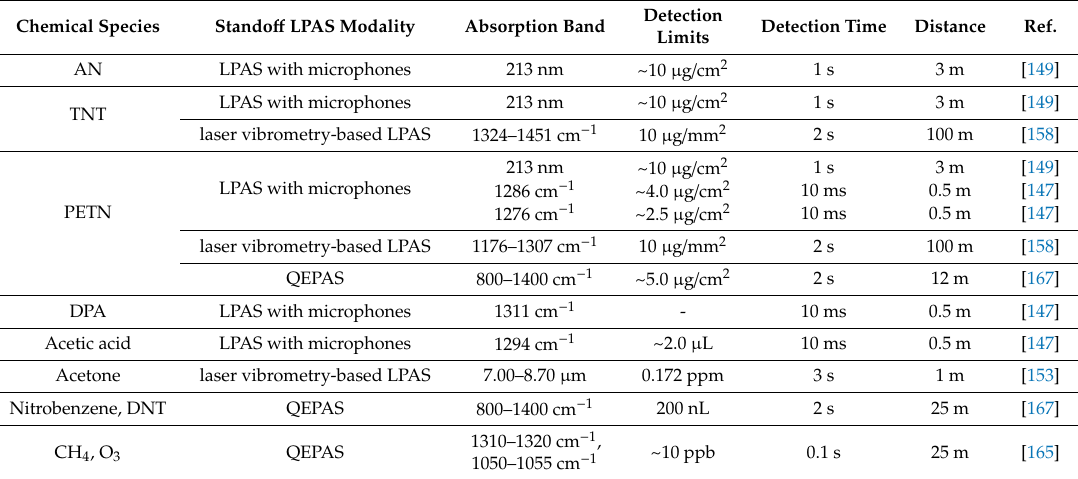
Table 4. Comparison of the three modalities of stando ff LPAS